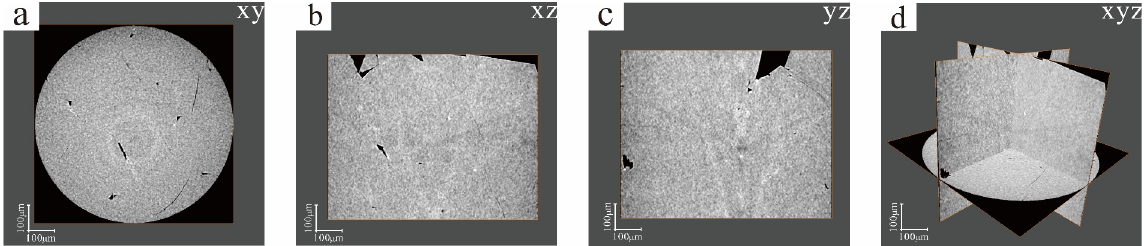
Figure 14. Micro-CT slice image of sample HZ-12 in the Huize lead–zinc deposit.( a ) Sample xy section Micro-CT scan image; ( b ) Sample xz section Micro-CT scan image; ( c ) Sample yz section Micro-CT scan image; ( d ) Micro-CT scanning mosaic image of sample xyz section The skeleton extraction was performed on the pore throat network of the slice using the application software, and its spatial distribution model is shown in Figure 15a–c. Sam- ple HZ-12 had many large pores with a good connectivity and generally isolated small pores. The lowest gray part (pore and pore throat) in the gray image was extracted and segmented using threshold segmentation to separate the pore and the pore throat from the rock matrix. The Avizo 9.2 software was used to segment and extract the distribution positions, distribution forms and distribution of the pores and throat networks in the sam-